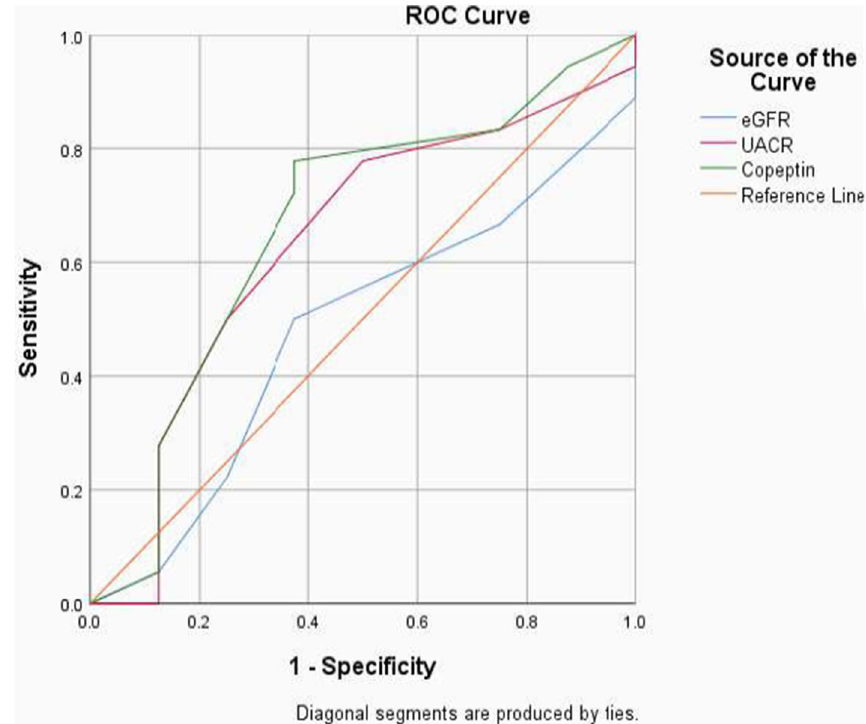
Fig. 4 ROC curve analysis of eGFR and UACR and copeptin implicated in the pathogenesis of diabetic nephropathy. Figure shows that copeptin is an excellent predictive biomarker and very sensitive parameter for diabetic nephropathy. Abbreviations: eGFR; Estimated Glomerular filtration rate, U; Urinary, ACR; albumin‑to‑creatinine ratio